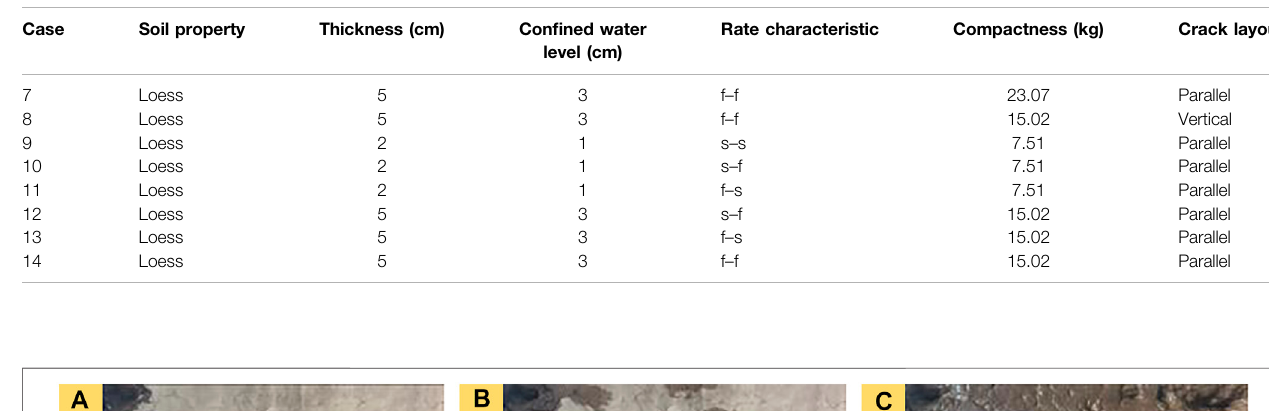
TABLE 3 | Test design of loess erosion.